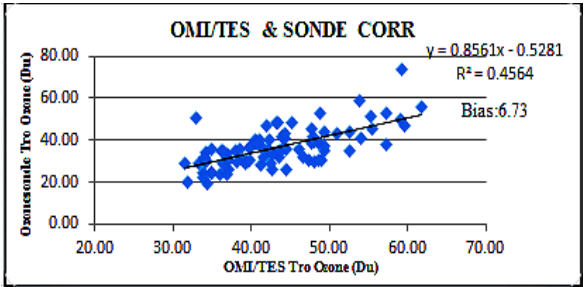
Figure 8 - tropospheric ozone solidarity OMI/TES and Ozonesonde in urban